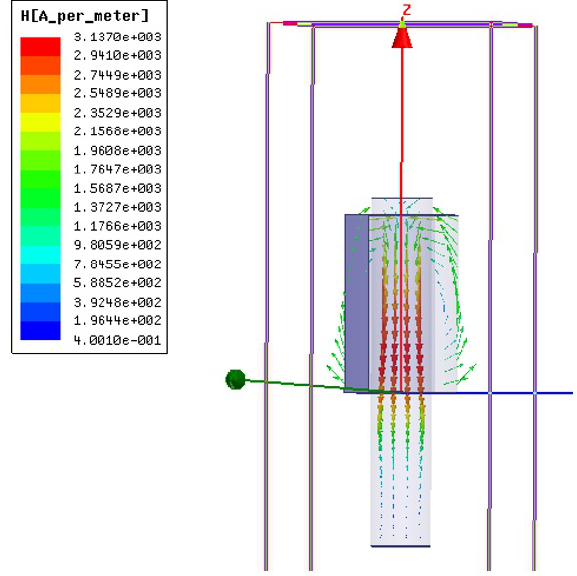
Fig. 7. Distribution of magnetic field strength.